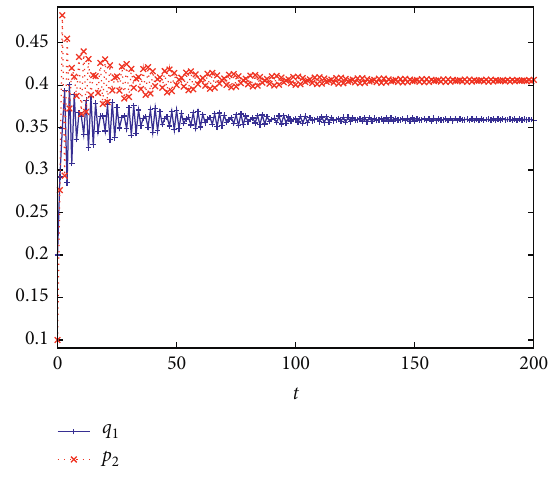
Figure 14: The time series plots of p